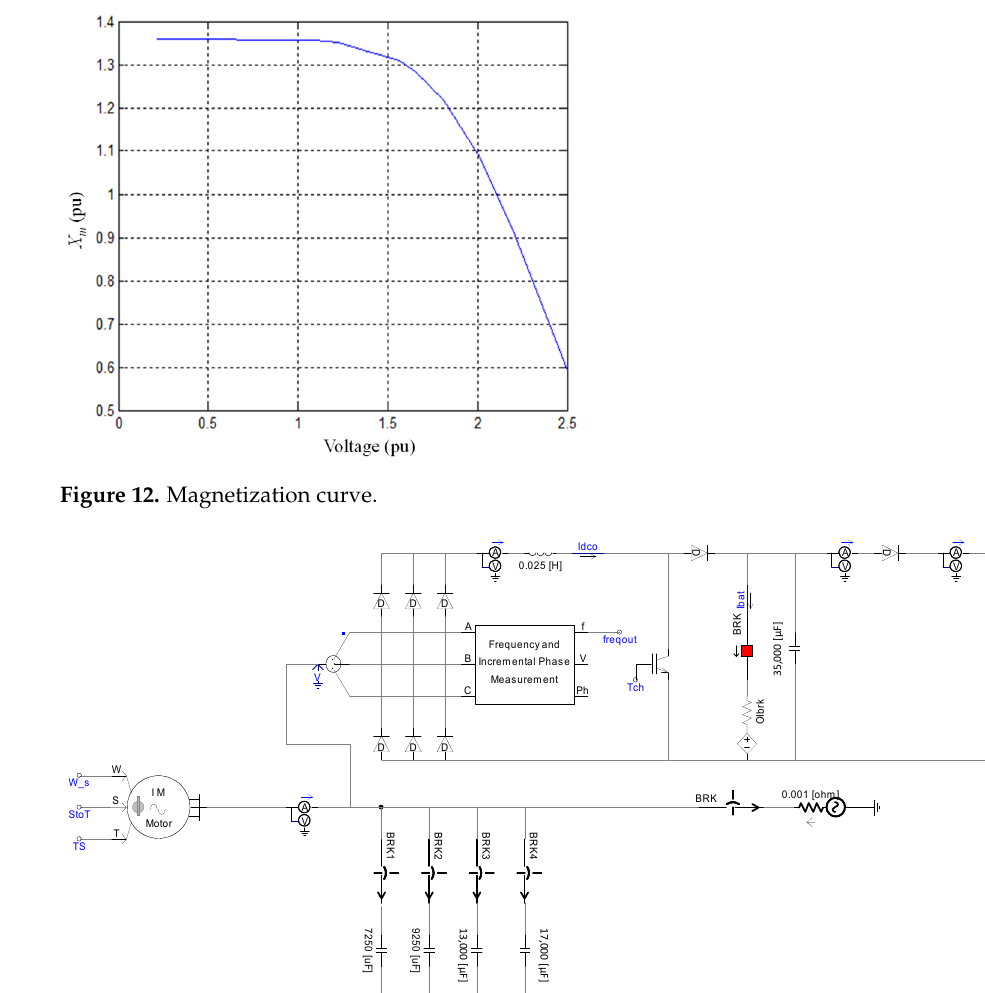
— Figure 11. Active power controller for the converter. 3. Computer Simulation Analysis and Discussion According to the analysis in Section 2, the series capacitor could be placed. However, in Figures 8 and 9, the ratio of C s / C p is above 45, which means most likely that the series capacitor acts as the short circuit during the operation. In addition to this capacitor ratio, the magnetizing saturation curve is seen in Figure 12 from the PSCAD model. In our sim- ulation, the series capacitor compensated for the magnetization losses is not considered, but only the parallel capacitors compensated for the leakage losses are placed, as seen in Figure 13. The reference flux is determined by the reference input voltage (480 V) and the reference frequency (60 Hz), as seen in the block diagram of Figure 14. The actual flux can be estimated from the measured voltage of the generator and the frequency of the three- phase diode rectifier through low pass filters which provide a smoother form of the sig- nals, removing short-term fluctuations, as shown in the block diagram of Figure 15. The